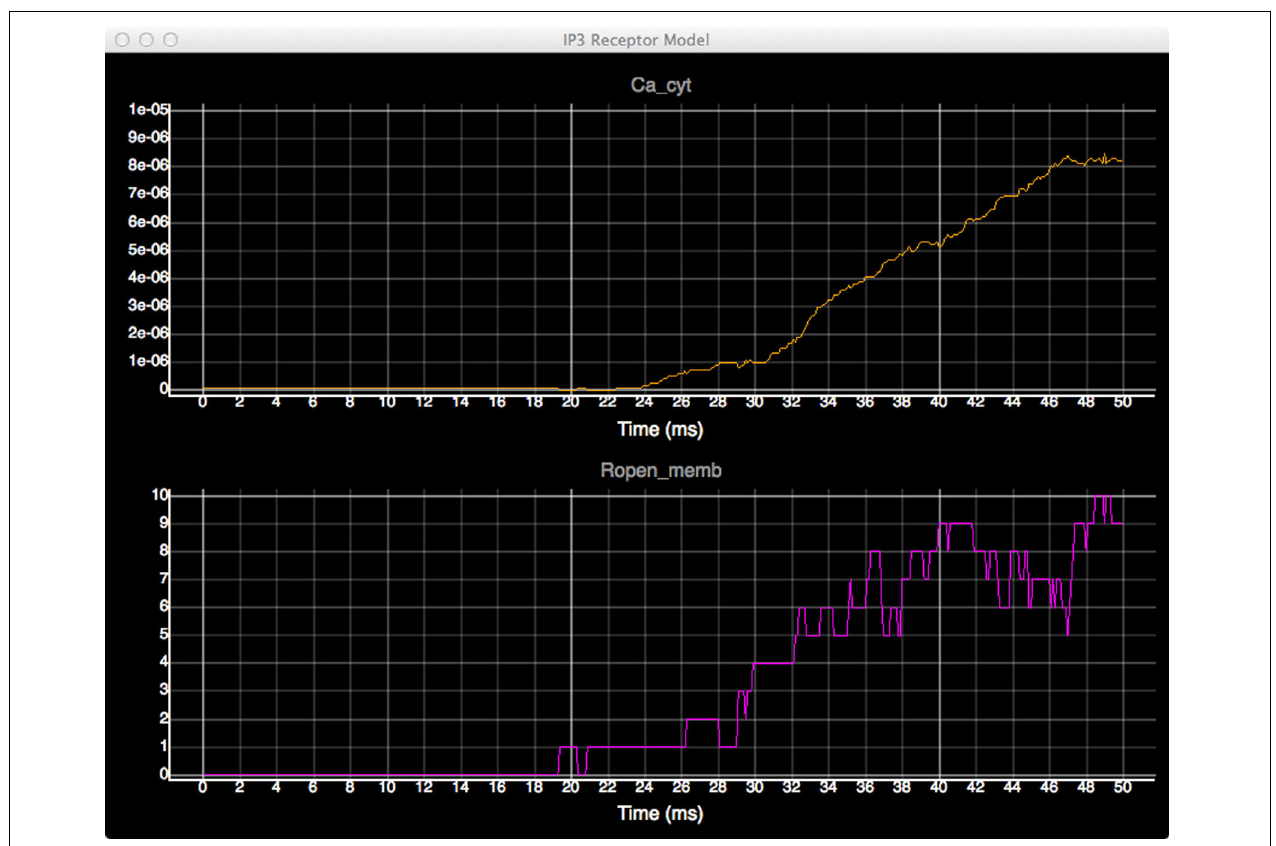
FIGURE 7 | Plots of cytosolic Ca 2 + concentration (top) and the amount of IP 3 receptors in open state (bottom) over time.